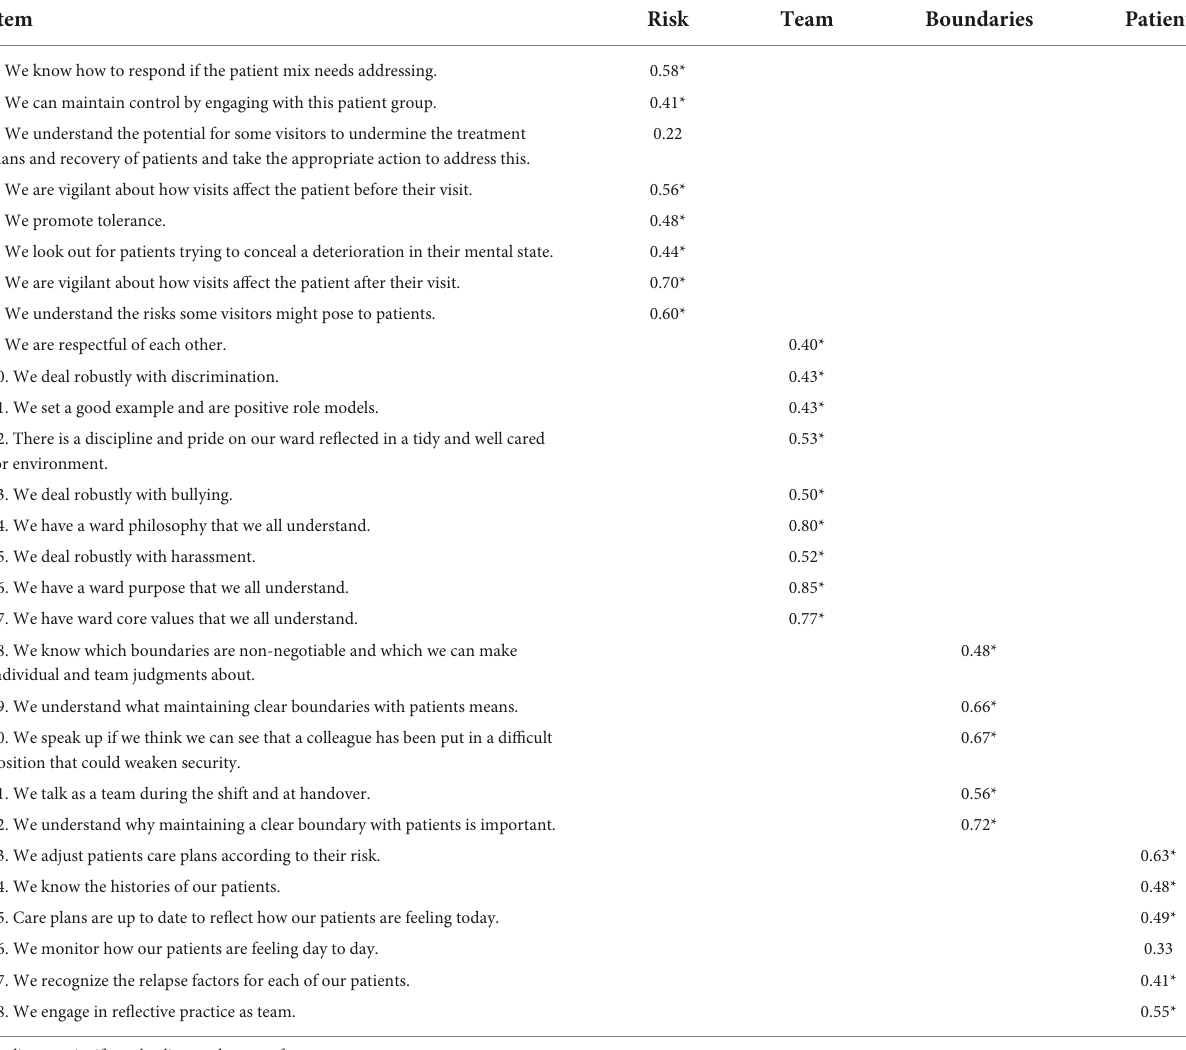
TABLE 2 Standardized factor loadings CFA of the See, Think, Act scale. Item